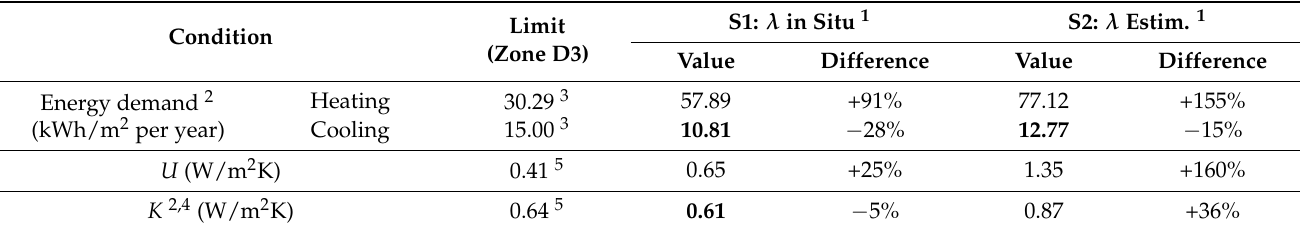
Table 11. Compliance (in bold)/no compliance with the Spanish code: CTE DB HE 1. Simulations using CE3X software. In bold: values that would comply with the Spanish energy saving standard. S1: λ in Situ 1 S2: λ Estim. 1 Limit Condition (Zone D3) Value Difference Value Difference Energy demand 2 (kWh/m 2 per year)